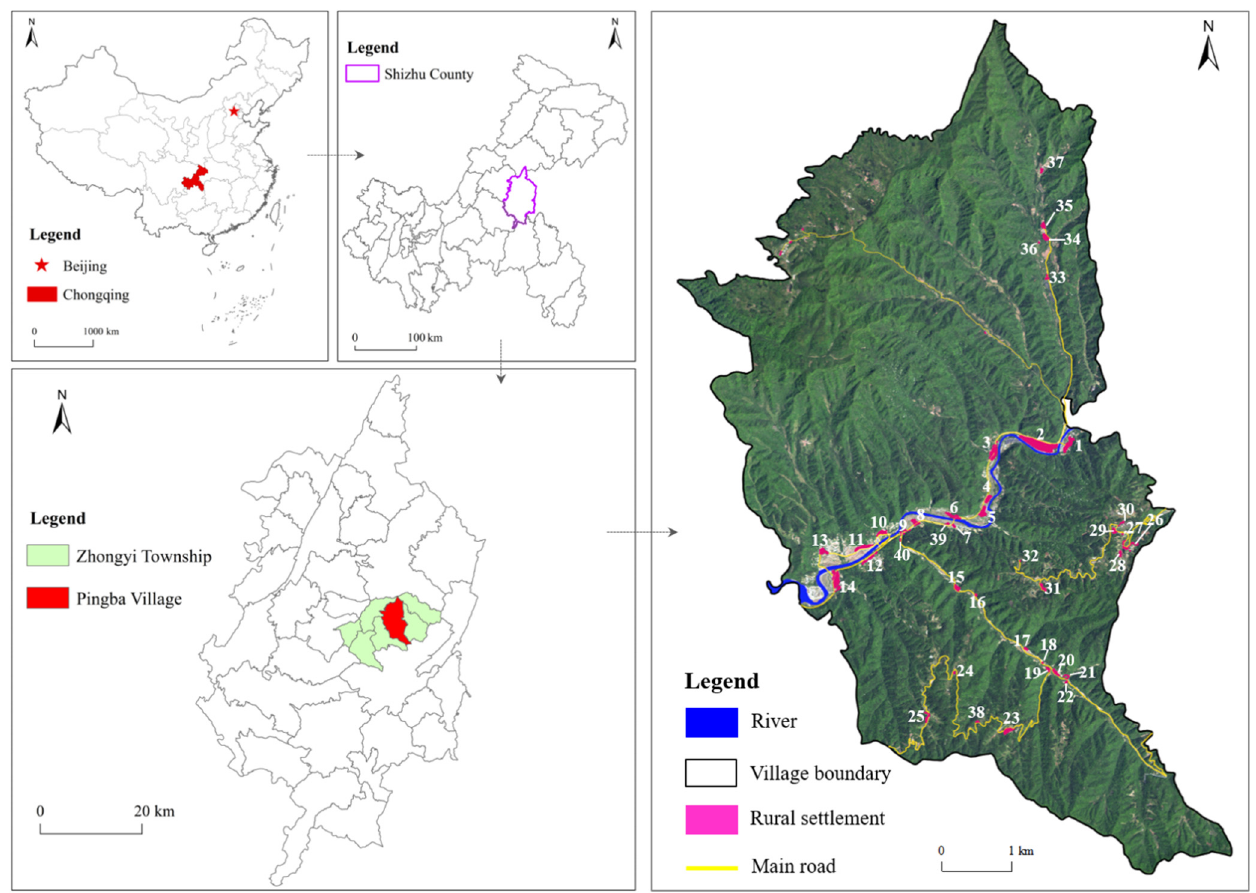
Figure 1. The geographic location of the study area and the numbering map of rural settlements. The white numbers in the figure is the number of rural settlements.